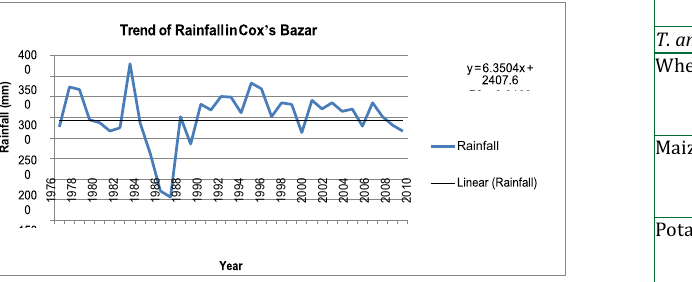
Figure 7: Long term (1950-2010) trend of annual tota l rainfall in Cox’s